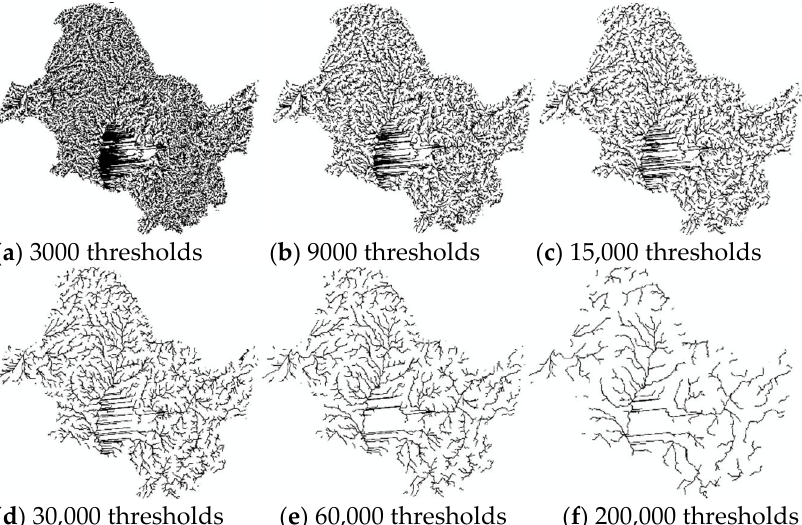
Figure 2. Map of the river network under different thresholds in the SRB. As the thresholds become larger, the slope network chain is gradually eliminated and the main rivers are revealed. The central plain with little elevation change generates a number of parallel river networks.